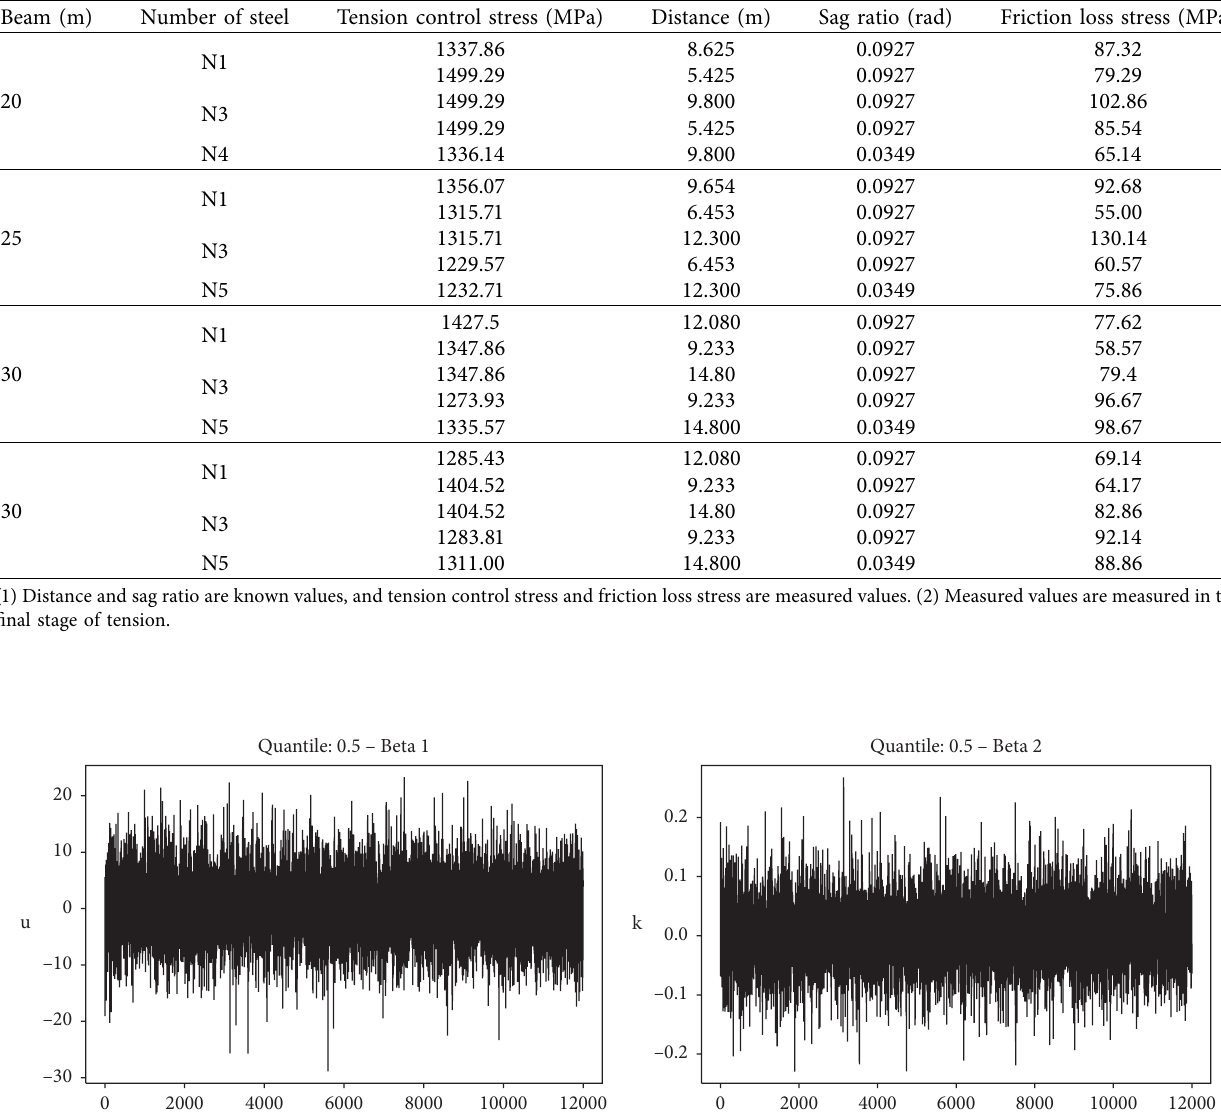
Table 3: Full-scale field test measured values.